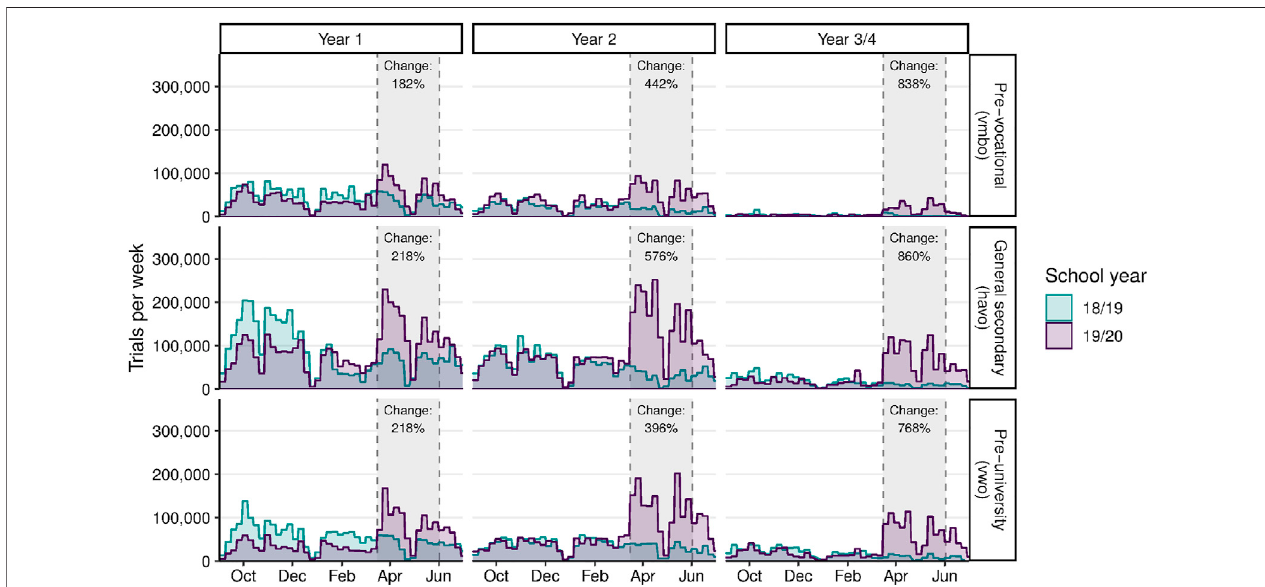
FIGURE1| ComparisonofFrench-languagestudyactivityduringaregularschoolyear(18/19)andtheschoolyearaffectedbyCOVID-19(19/20),strati fi edbyyear group (columns) and education track (rows). Activity is measured through the number oftrialscompleted per week. The shaded area marks the schoolclosure period in the 19/20 school year. The change in activity during this period is shown as a percentage in each